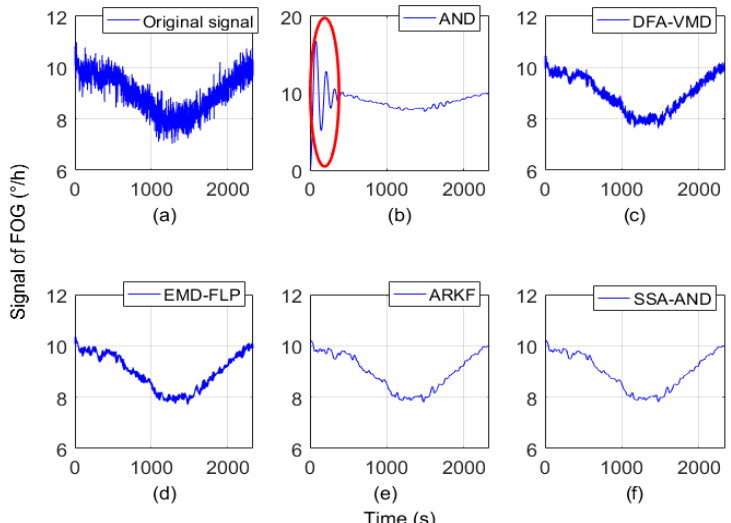
Figure 6. Comparison results of different de-noising methods for the signal of FOG2: ( a ) original signal; ( b ) signal de-noised by AND, where R = 0.5; ( c ) signal de-noised by DFA-VMD; ( d ) signal de-noised by EMD-FLP; ( e ) signal de-noised by ARKF; ( f ) signal de-noised by SSA-AND.